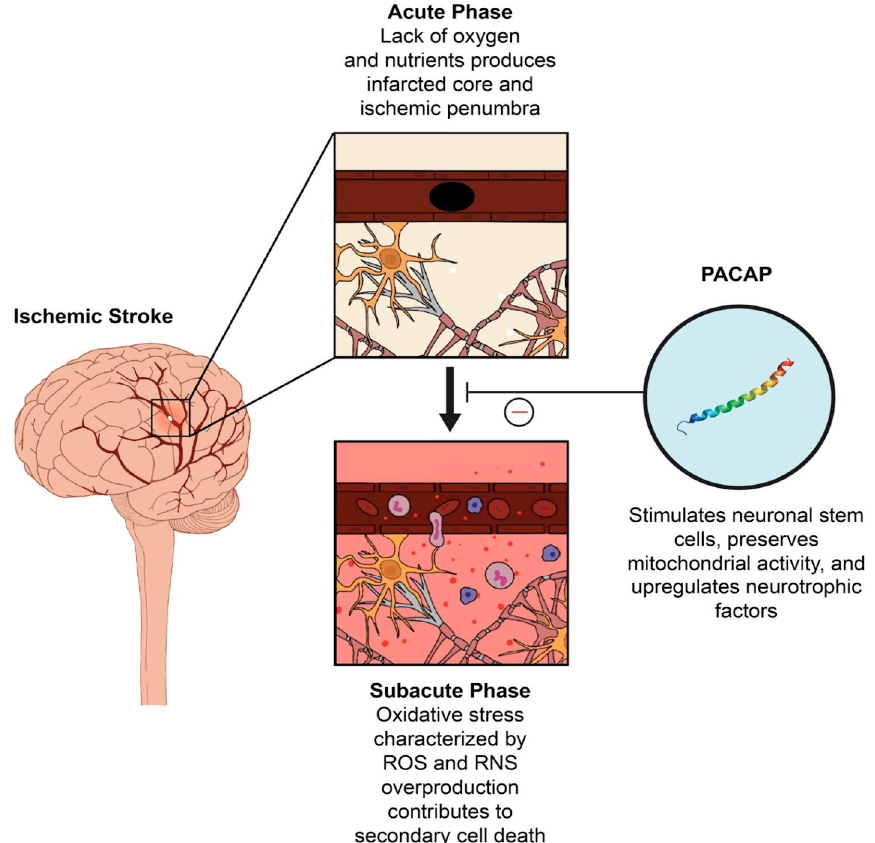
Figure 1. Ischemic stroke entails an acute phase and a subacute phase. In the subacute phase, oxidative stress triggers secondary cell death. Pituitary adenylate cyclase-activating polypeptide (PACAP) may serve as a potent therapeutic intervention in the subacute phase, as it combats oxidative stress and imparts neuroprotection. Reactive oxygen species (ROS) and reactive nitrogen species (RNS).